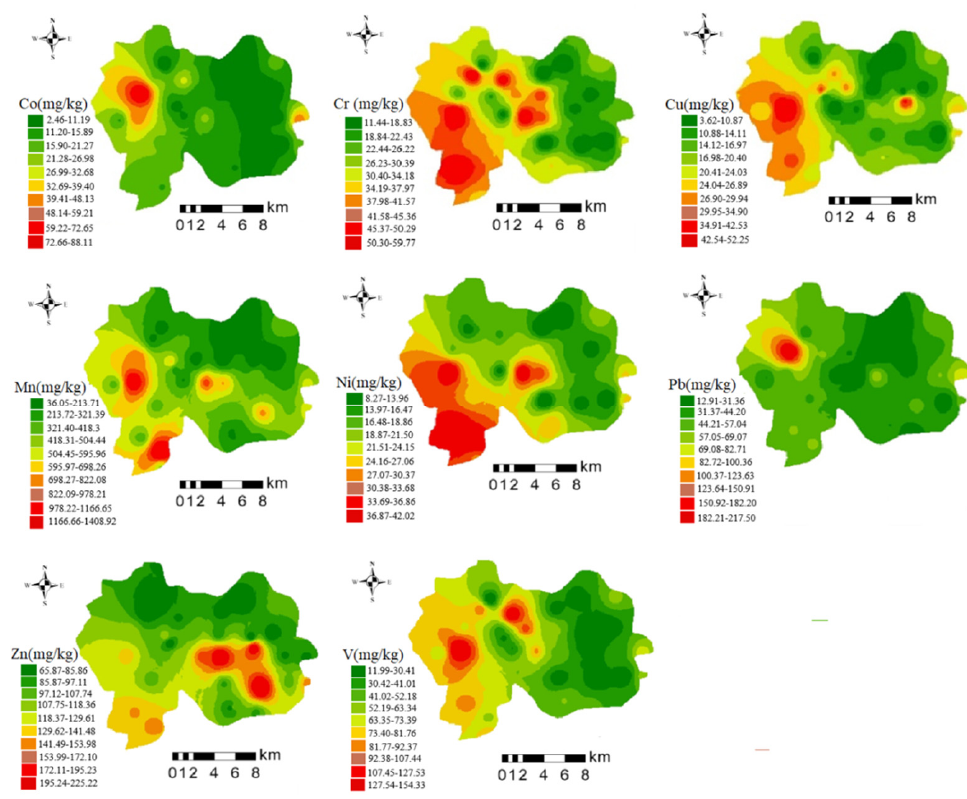
Figure 3. Spatial distribution of potentially toxic-element concentrations in soil.